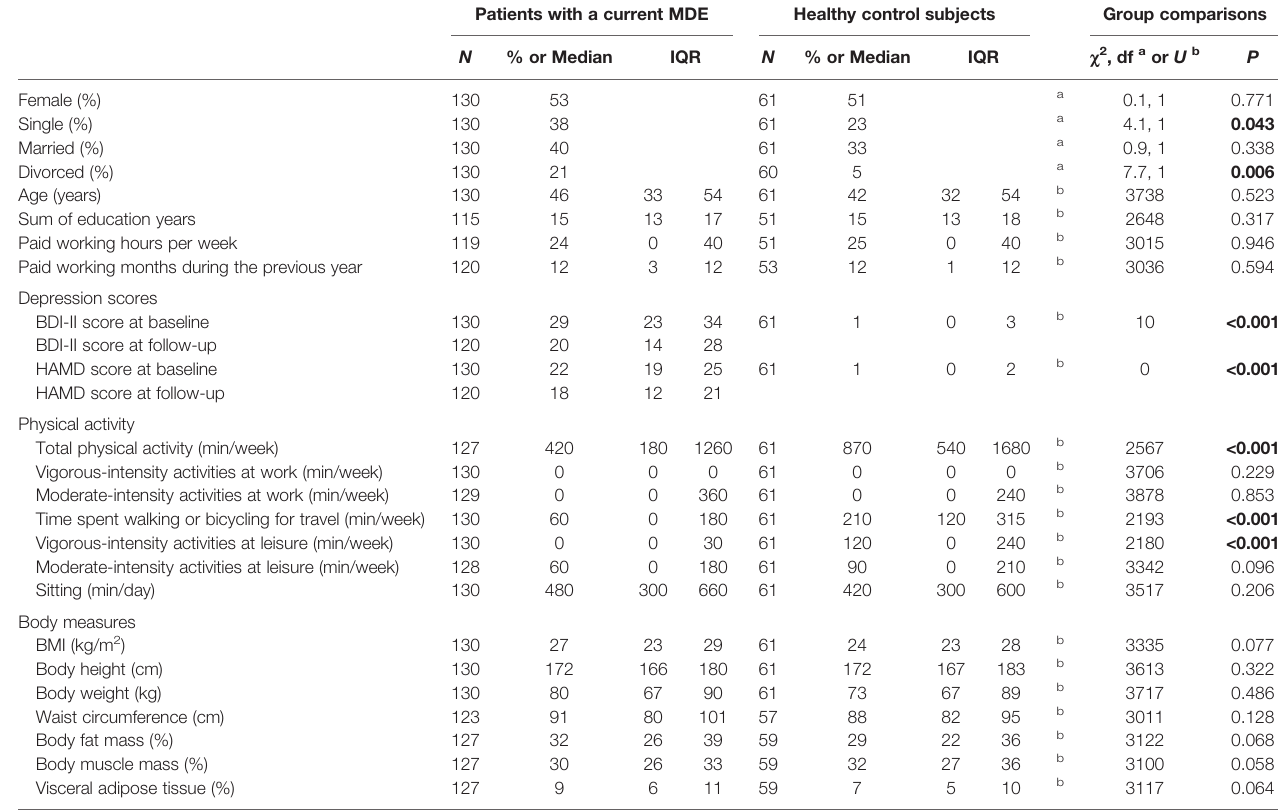
TABLE 1 | Study cohort and group